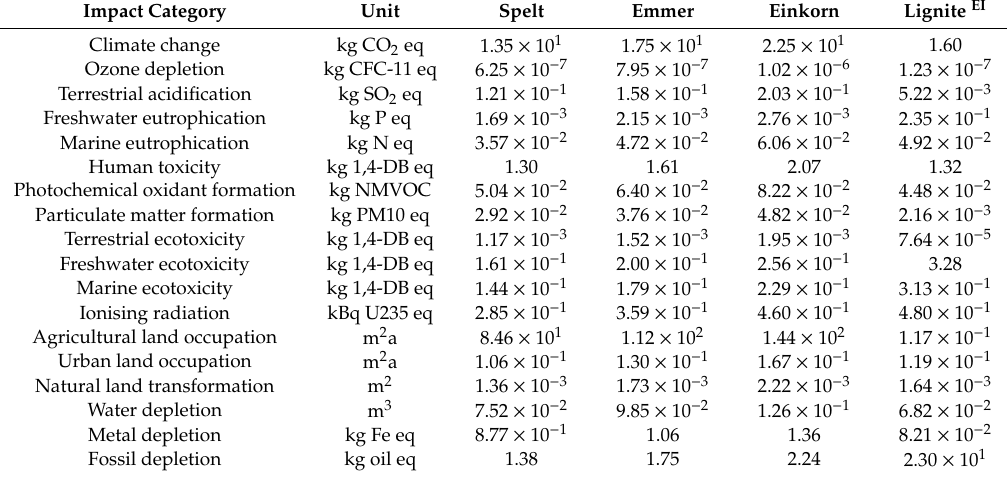
Table 7. Environmental load per 1 GJ of potential energy